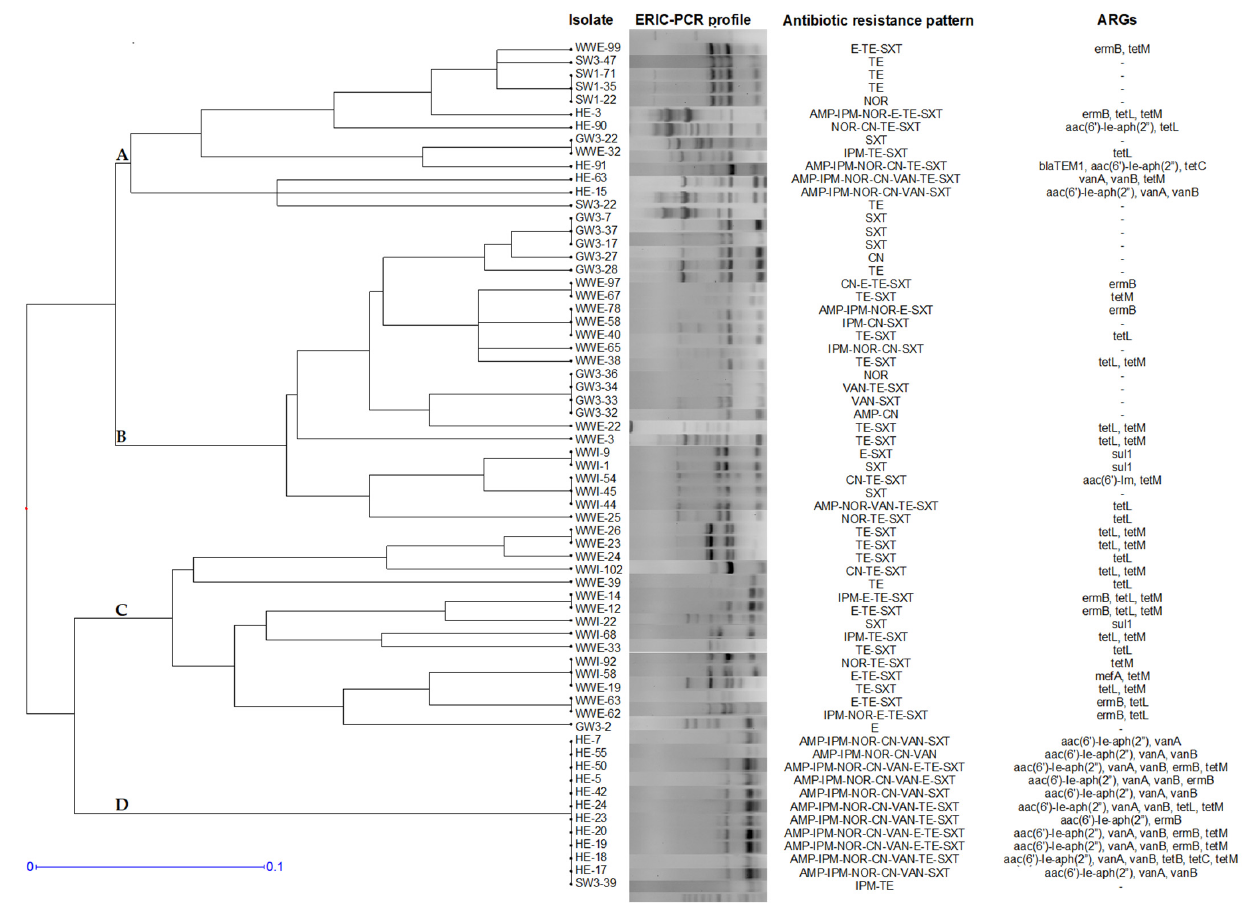
Figure 5. ERIC-PCR dendrogram and antibiotic resistance profiles of E. faecium isolates. The isolates were labelled by sources: GW = groundwater; HE = hospital effluent; SW = surface water; WWI = wastewater influent; WWE = wastewater effluent.